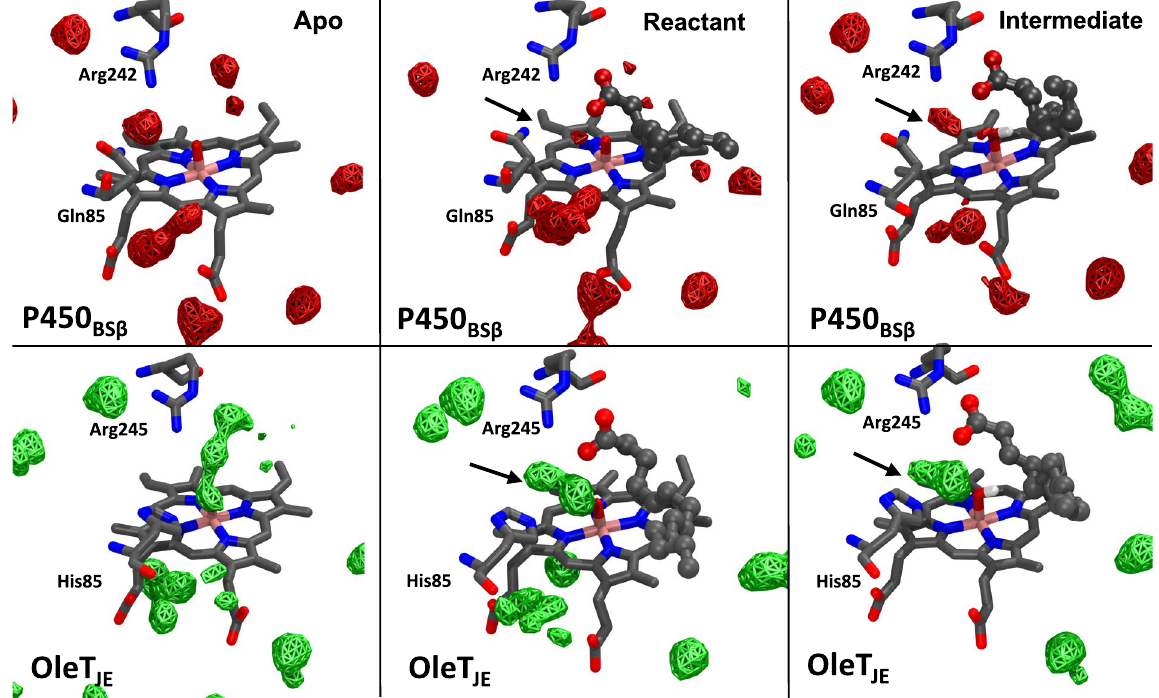
Figure 8. Active site water occupancies: Volumetric occupancies of water calculated within 10 Å of heme in various states-apo, compound I and compound II-are depicted as wire frame structures in P450 BS β (red) and OleT JE (green). The wireframe volumes signify atleast a 75% occupancy of water calculated using 15000 frames over 150 ns trajectories in each state. The arrows point to key water occupancies that might occlude substrate rebound onto the heme